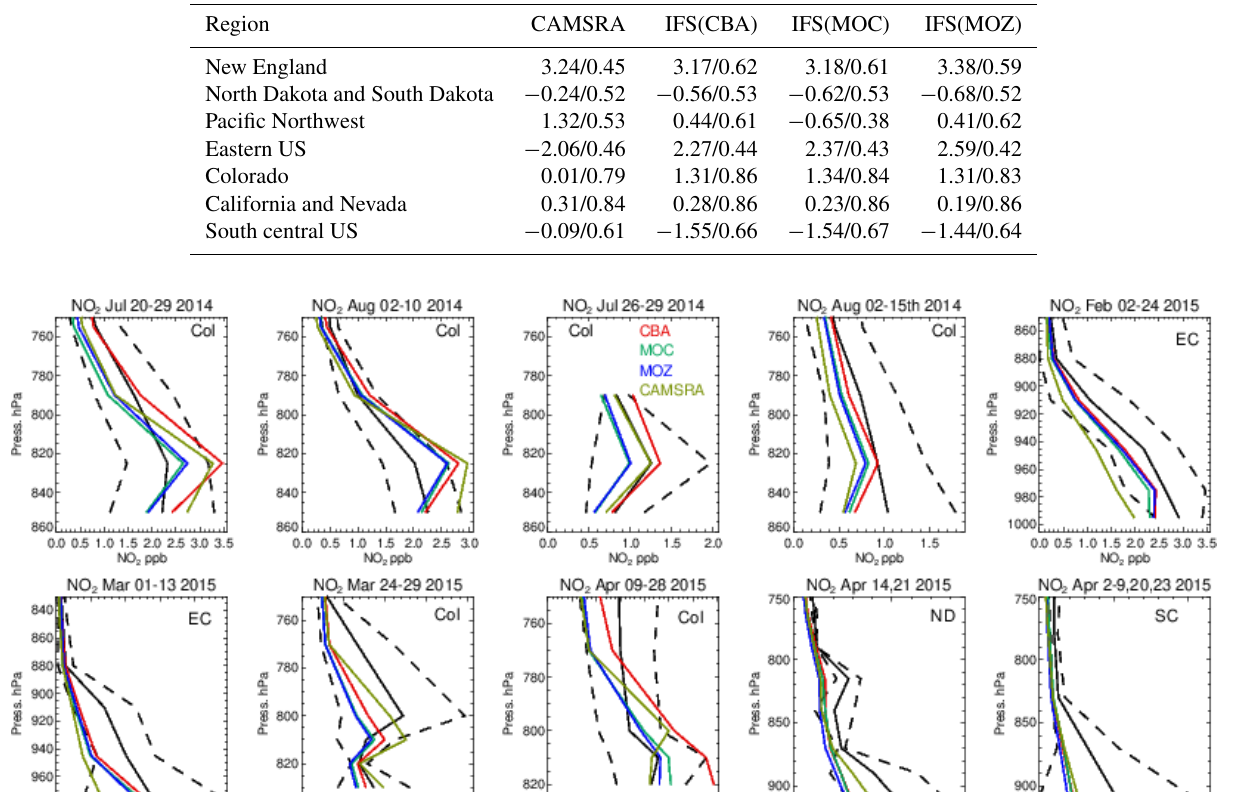
Table 9. Annual mean biases (µgm − 3 ) and Pearson’s R values for the comparison of surface NO 2 versus AirNow data for 2014.